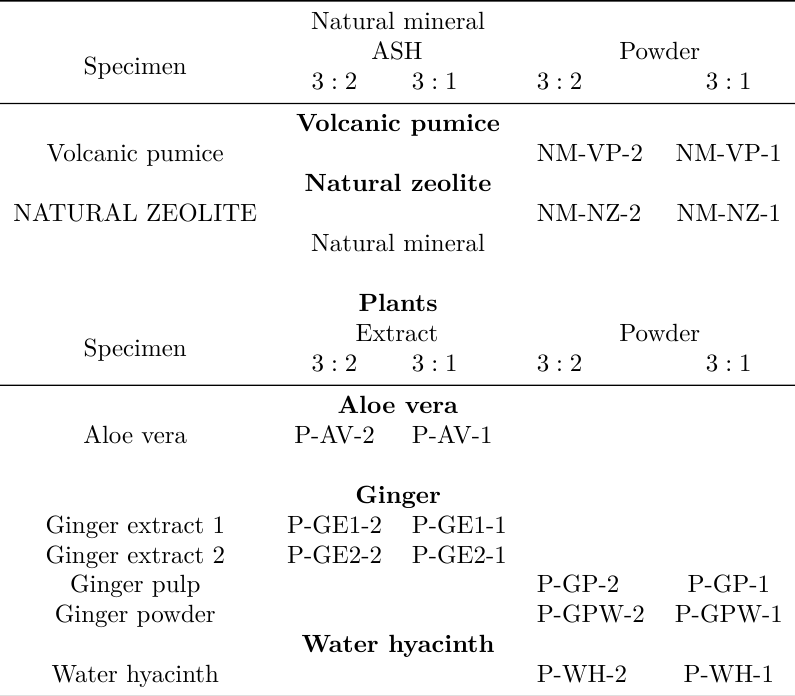
Table 4. Natural and plants as candidate materials in reducing DO